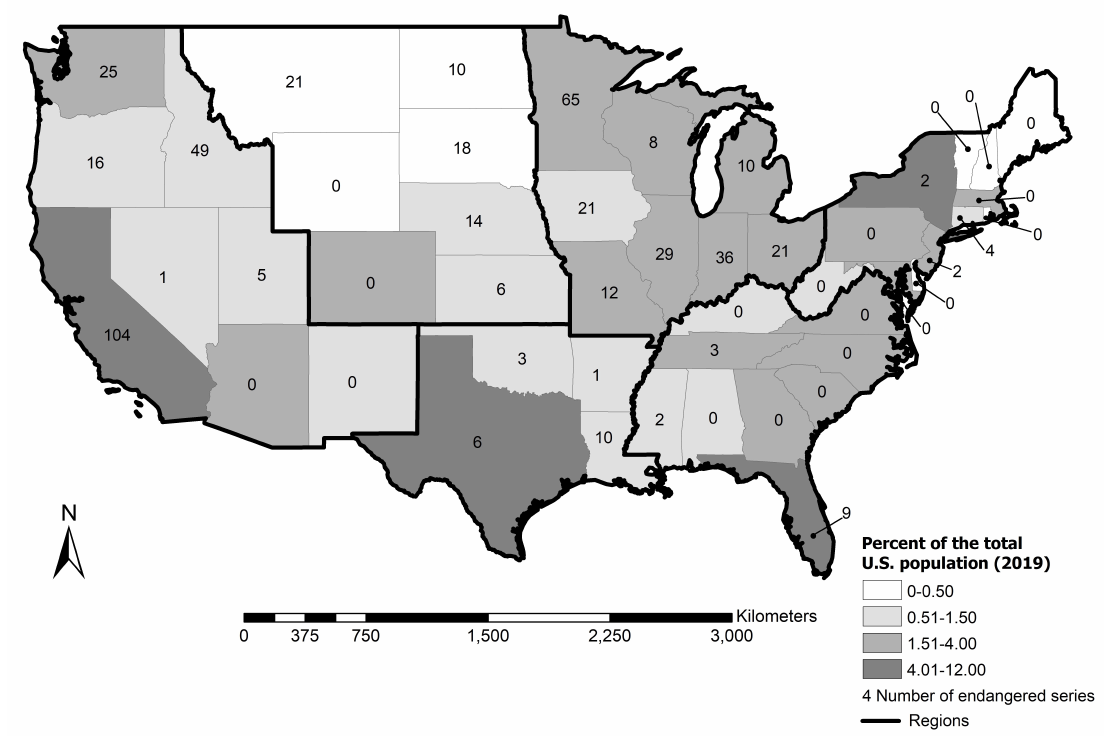
Figure 5. Number of endangered soil series [2] and percent of the total U.S. population (2019) [60] in the contiguous United States